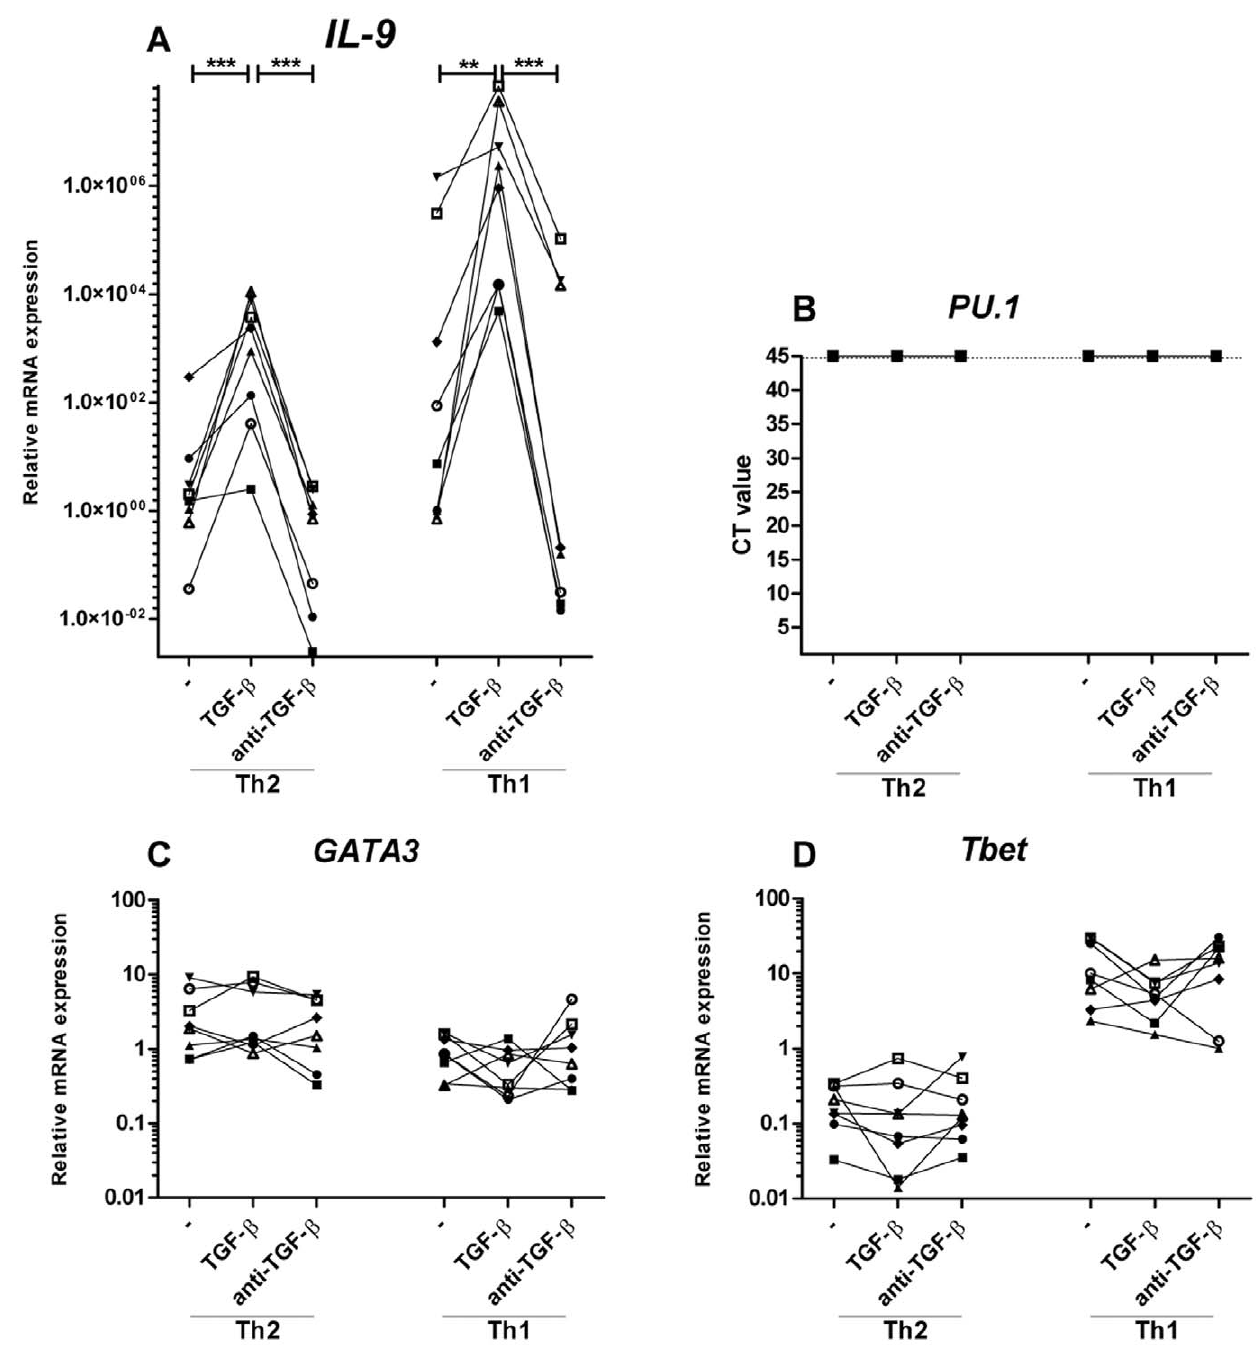
Figure 3. TGF- b induces IL-9 mRNA expression in Th1 and Th2 cells. Naı¨ve CD4 + T cells were activated with fibroblast-bound anti-CD3/CD28 under classical Th1 and Th2 conditions, with IL-12 and anti-IL-4 or IL-4, anti-IFN- c , and anti-IL-12 respectively for 5 days, restimulated at day 5 and split in cultures with and without TGF- b or anti-TGF- b for 5 more days of stimulation. (A, C and D) qRT-PCR gene expression analysis of the relative gene expression of IL-9, GATA3, and Tbet at day 10 relative to the Th0 culture. (B) CT value from qRT-PCR gene expression analysis of the gene PU.1. Each donor is represented by a specific symbol and connected with a line. Data are from four independent experiments, each with two donors. * p , 0.05, ** p , 0.01, *** p , 0.001. doi:10.1371/journal.pone.0021695.g003 (Invitrogen) in a total volume of 12 m l and incubated for 10 qRT-PCR minutes at 70 u C to denature the RNA. The RNA was transcribed Relative mRNA expression levels were determined by qRT- to cDNA using Superscript II reverse transcriptase (Invitrogen) at PCR using the ABI PRISM 7700 sequence detection system from 42 u C for 50 minutes followed by heat inactivation of enzymes at Applied Biosystems (Carlsbad, CA, USA). For each triplicate 70 u C for 10 min. The cDNA was stored at 2 20 u C. qRT-PCR analysis, 1.5 m l cDNA was mixed with 12 m l water,